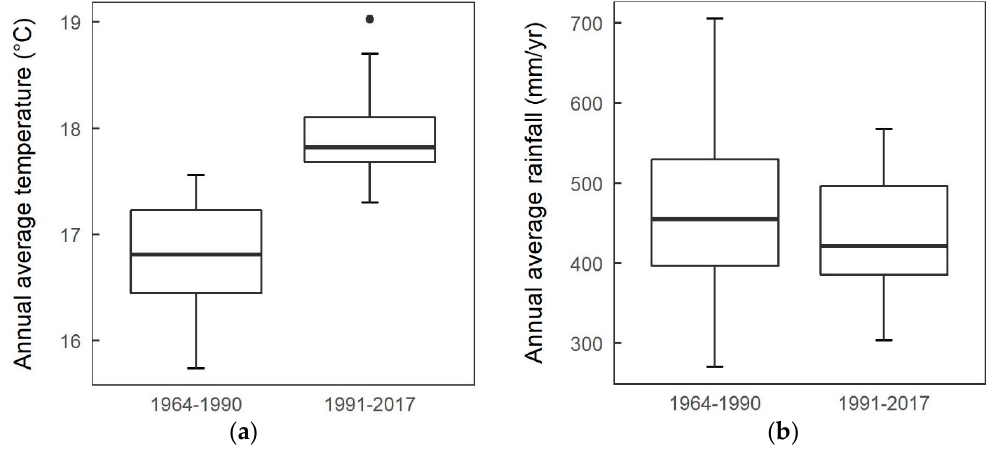
Figure 2. Median and variation in annual values of ( a ) mean temperature and ( b ) total rainfall at the